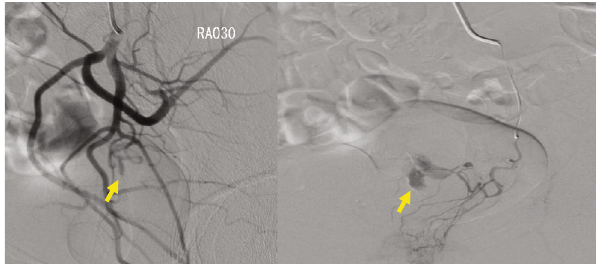
Figure 2: Pelvic angiography shows pseudoaneurysm formation in the left vaginal artery (arrows). (a) Angiography for the left internal iliac artery. (b) Selective angiography for the left vaginal